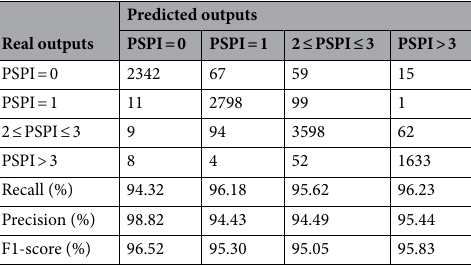
Table 2. Confusion matrix obtained for proposed shutter blinds model using UNBC-McMaster Shoulder Pain Expression Archive Database with tenfold cross-validation.